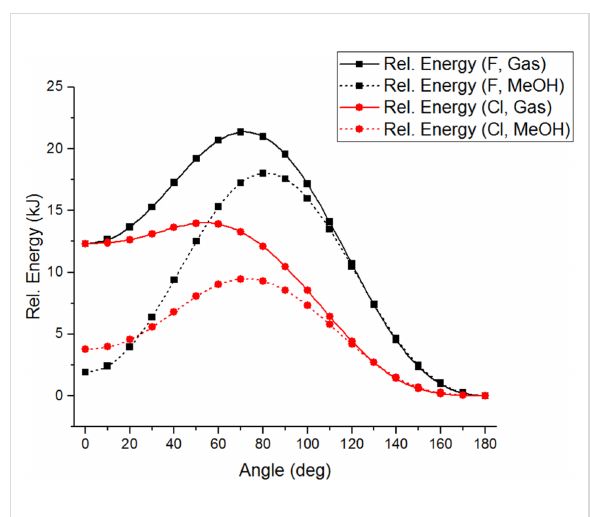
Figure 8: Conformational energy profiles of halogenated acetones in gas phase and in MeOH.